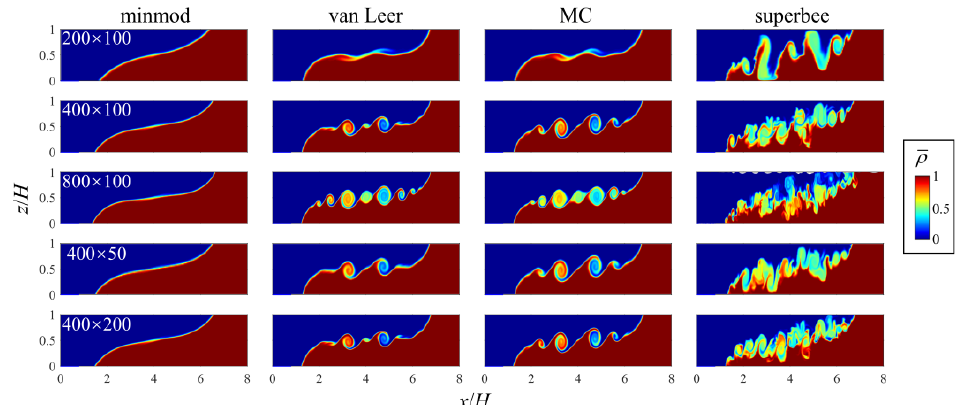
Figure 12. Comparison of density ( ρ = ρ − ρ 1 / ρ 2 − ρ 1 ) distributions for inviscid lock-exchange flows at t = 15.0 s with the different grid resolutions (top to bottom) and different slope limiters (left to right).